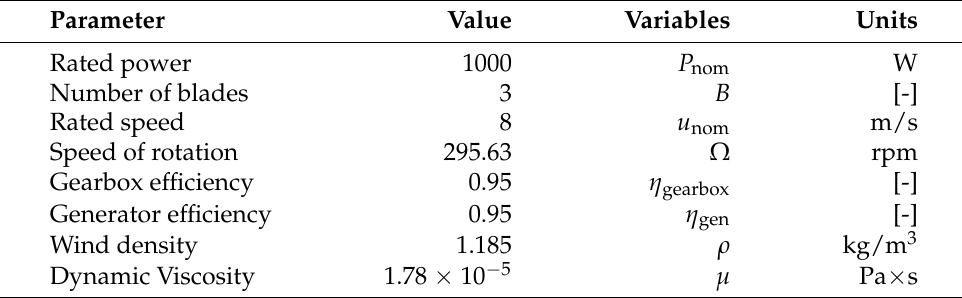
Table 1. Design parameters of the 1 Kw